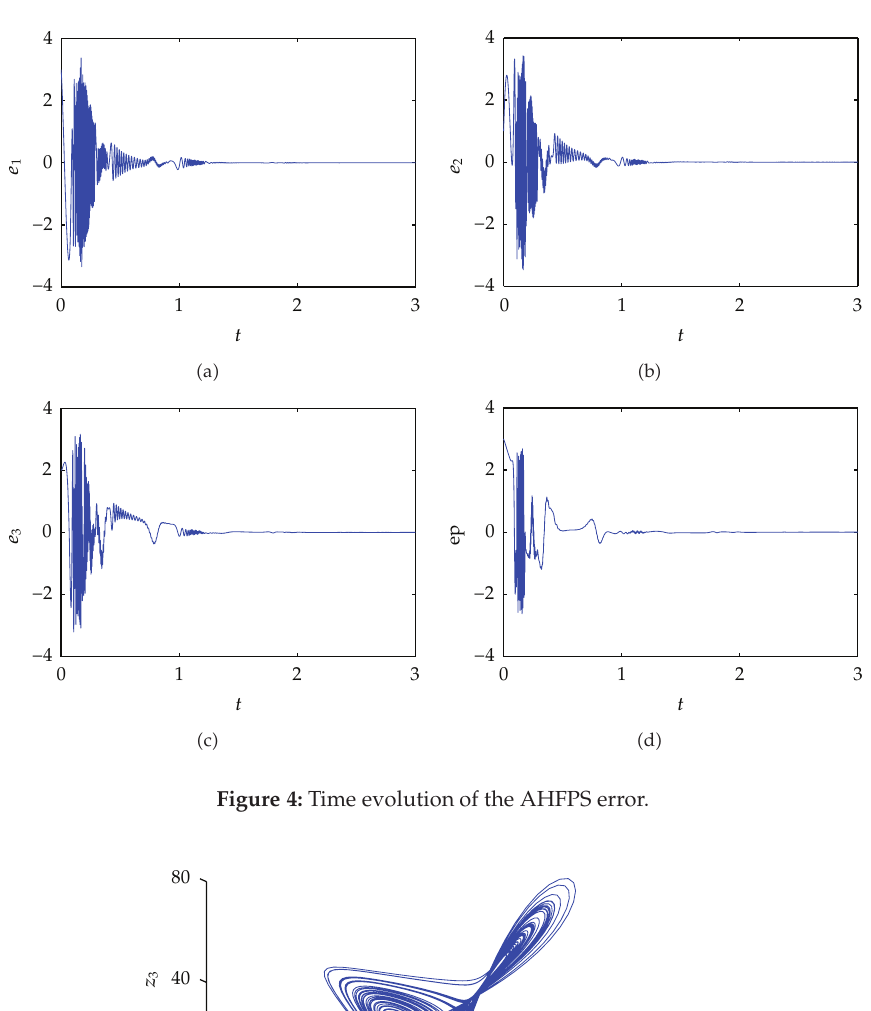
Figure 4: Time evolution of the AHFPS error.